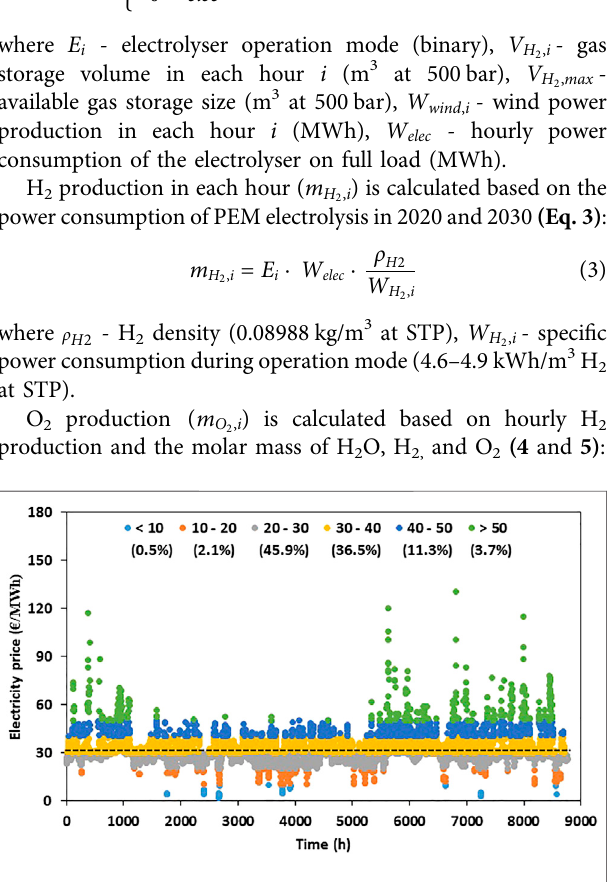
FIGURE 4 | Day-ahead price distribution in the spot market of the Nord PoolforSE3region.Note:Dottedlinerepresentstheaveragepriceintheyear.